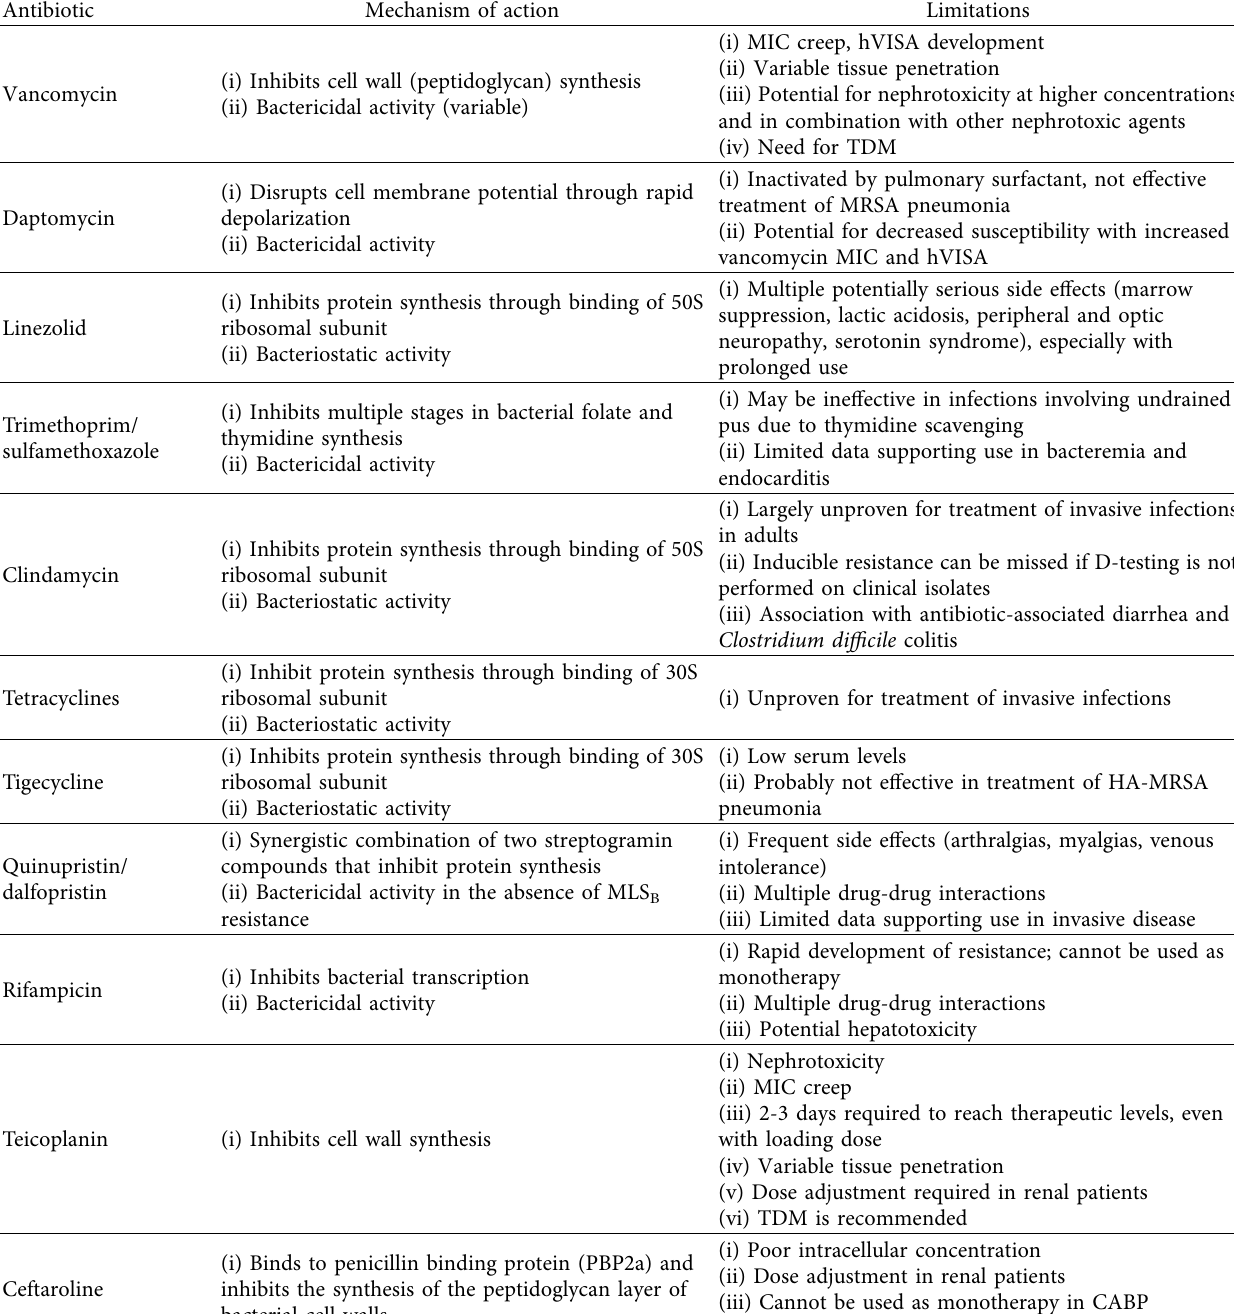
Table 1: Common limitations of the currently available anti-MRSA